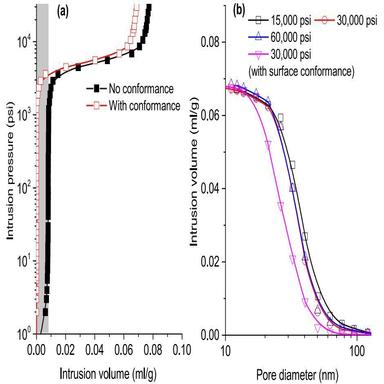
(a) Pressure-volume curves of P03-30 samples with and without surface conformance effect, (b) conformance-corrected TSDs of cement paste samples under different maximum intrusion pressures.